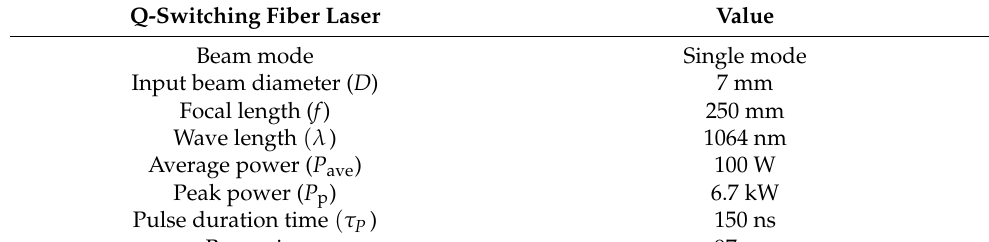
Table 2. Specification of laser cleaning equipment.